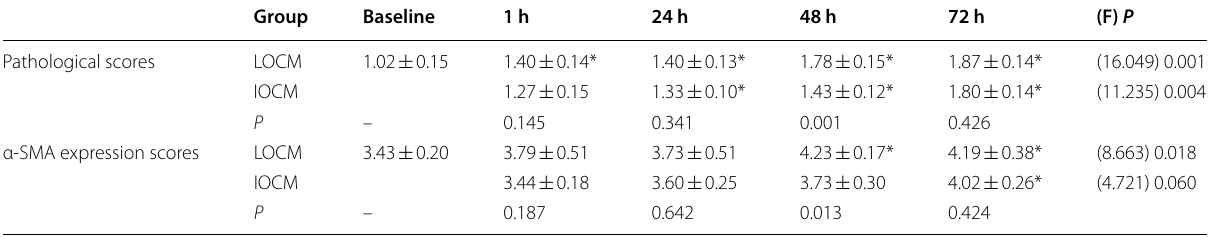
*Represents p < 0.05 versus